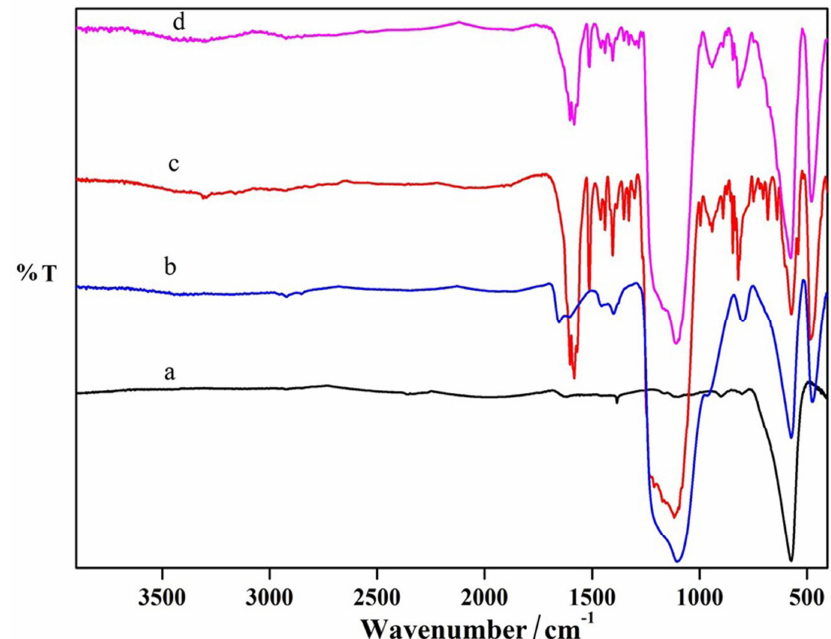
Fig. 1. FTIR spectra of the: a) Fe